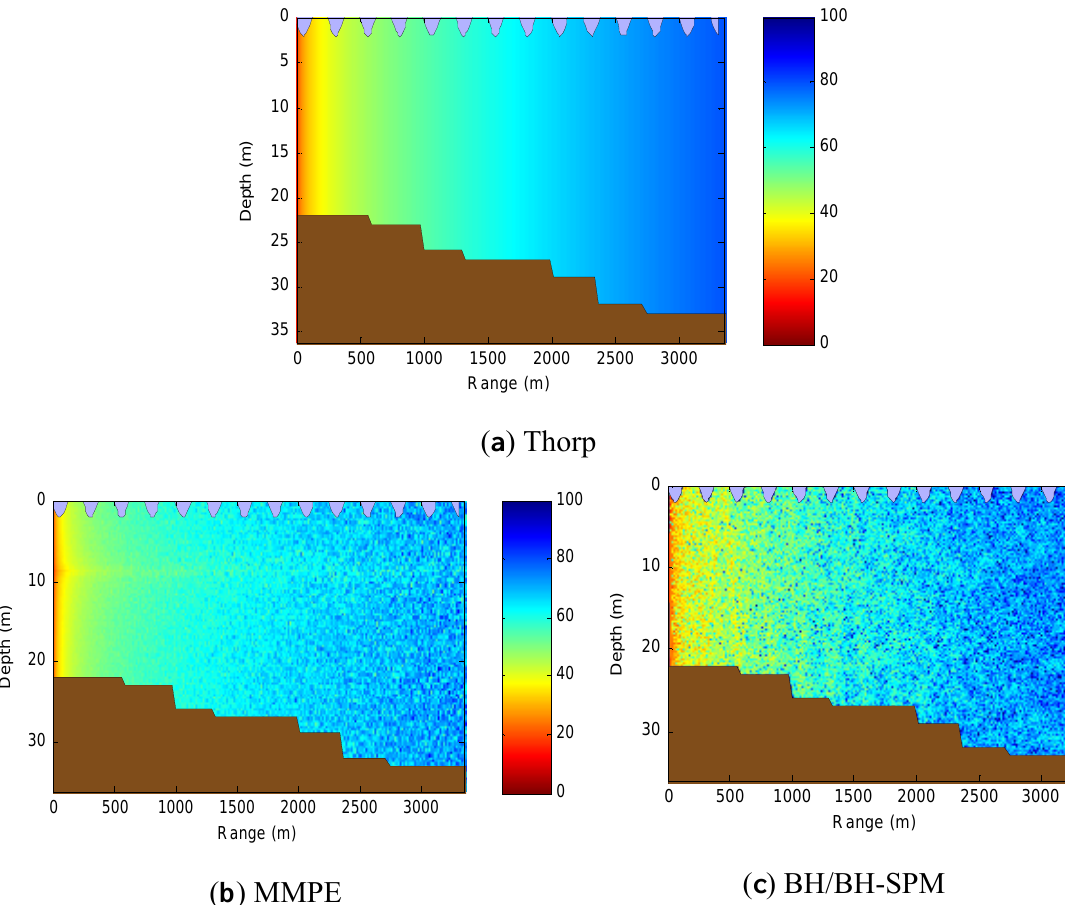
Figure 3. Attenuation of acoustic